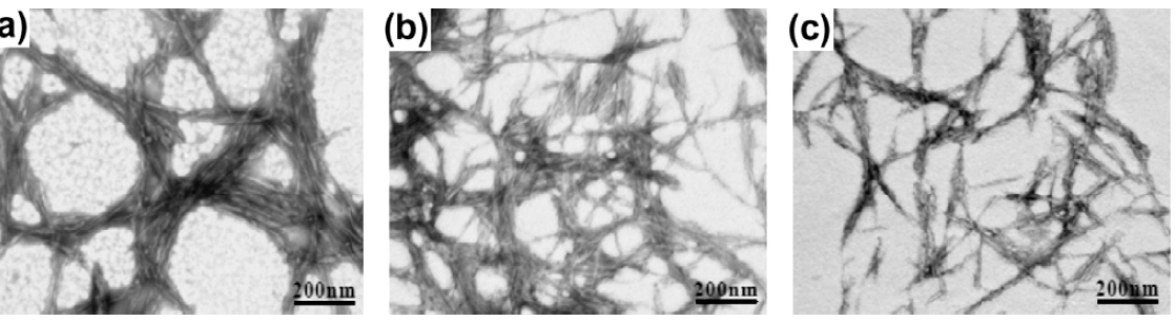
Figure 6. TEM images of cellulose nanowhiskers (CNW) treated using different ultrasonication times: ( a ) NCC-5 min; ( b ) NCC-10 min and ( c ) NCC-15 min. Reproduced with permission from [124]. Copyright 2012